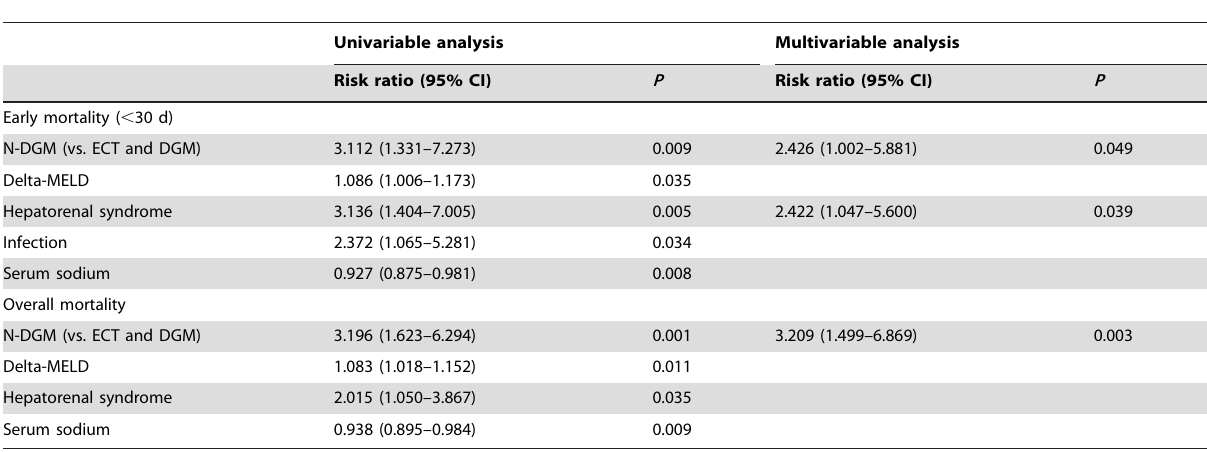
Table 2. COX regression for pre-transplant influence factors of patient death.